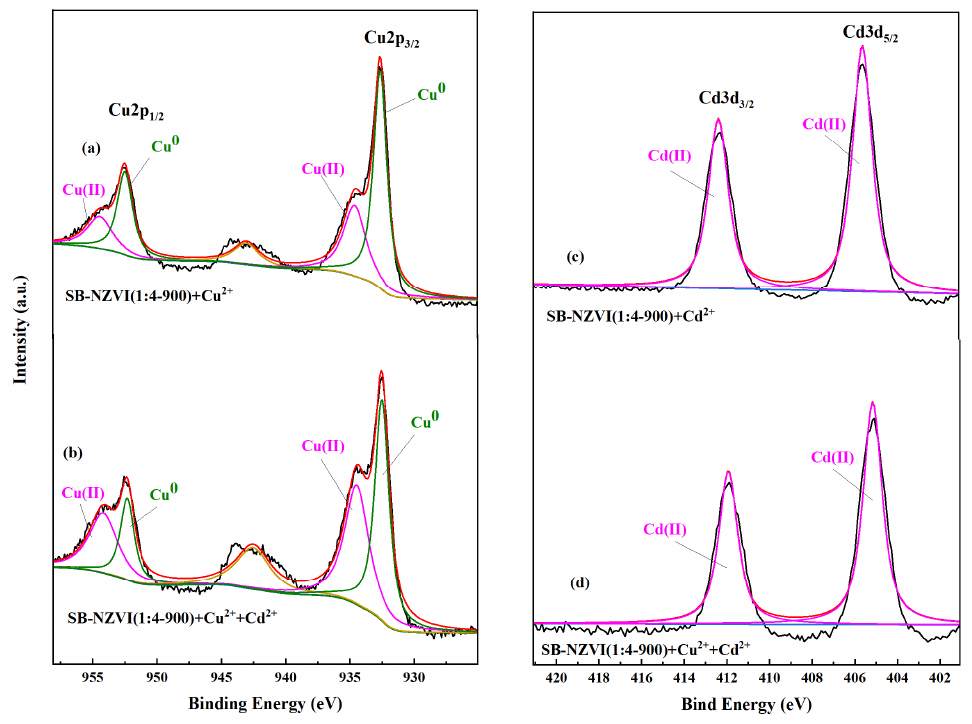
Figure 6. Cu 2p and Cd 3d narrow scan spectra of SB-NZVI(1:4-900) after reaction with ( a ) Cu 2+ , ( c ) Cd 2+ and ( b , d ) coexisting with two heavy metals.